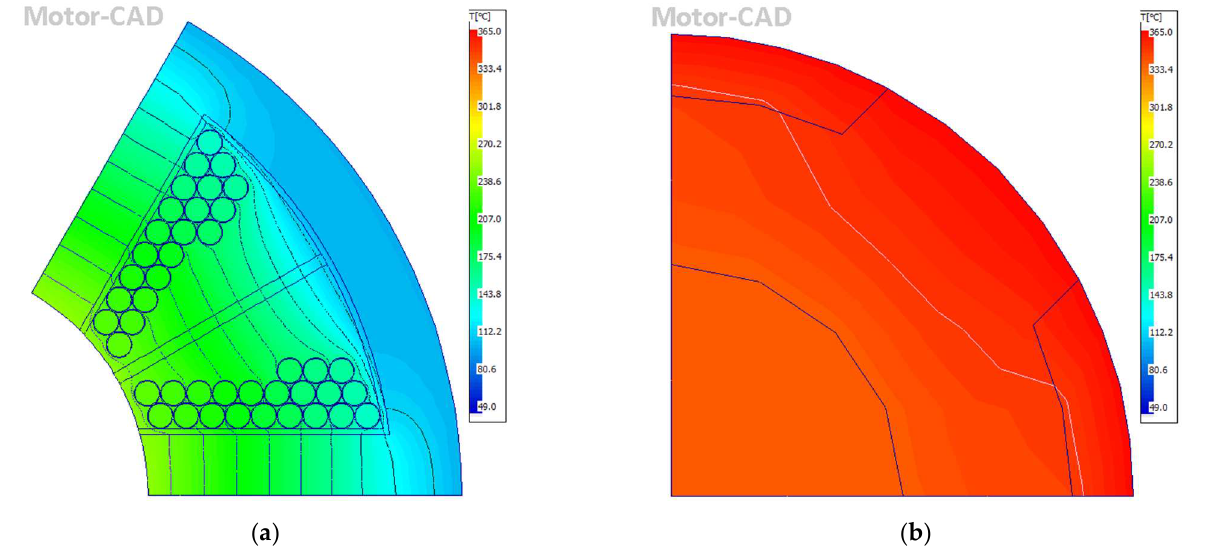
Figure 8. The distribution of temperature at steady state: ( a ) stator; ( b ) rotor.